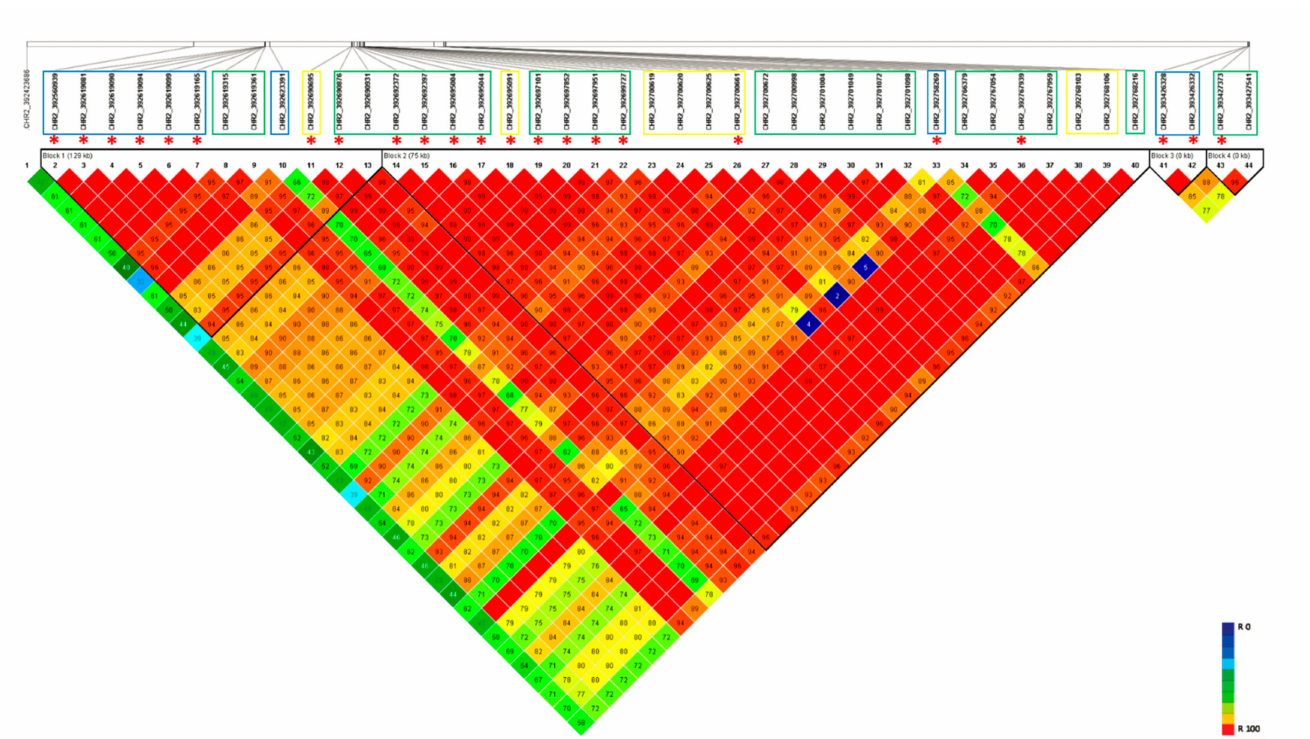
Figure 3. LD heatmap on Chromosome 2 haplotypic region using SNP markers generated from both GBS methods. Markers derived from each GBS method was highlighted using the colored box. Blue: markers from tGBS method; Green: markers from GBS-t method; and Yellow: markers common to both GBS methods. ‘ * ’ represents the significant marker positions identified in the current